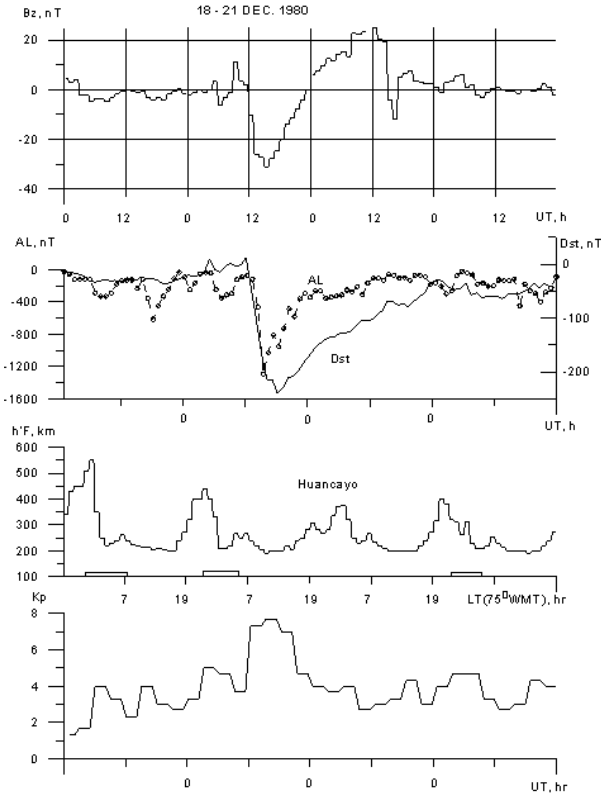
Fig. 2. Storm 2: 18–21 December 1980, Category 1 magnetic storm. The upper two panels show IMF B z , AL, and D st on the same time scale as K p . The rectangular bars along the local time axis of the h 0 F plot at Huancayo indicate the durations of observed